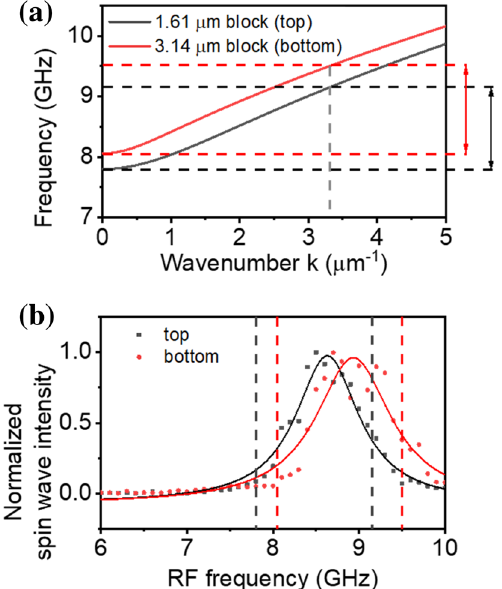
Figure 2. ( a ) Dispersion relation of the spin wave with mode number n = 1 for NiFe blocks 1.61 μm wide (black line) and 3.14 μm wide (red line). ( b ) Normalized spin wave intensity of the two NiFe blocks in terms of the excitation RF